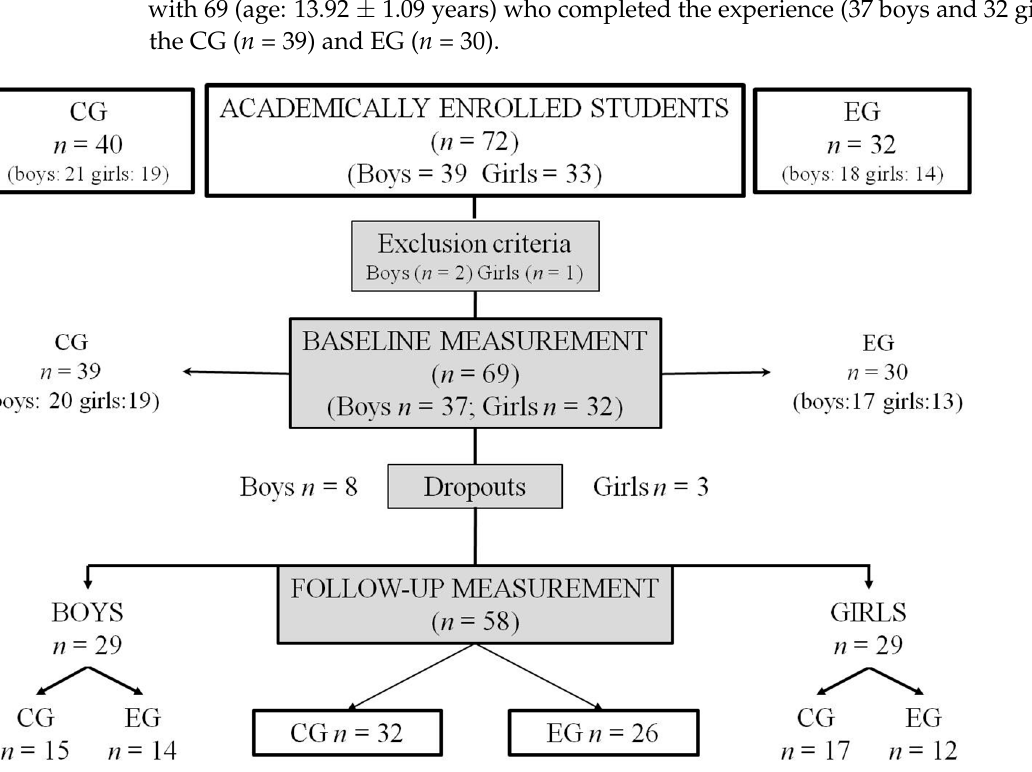
Figure 1. The flowchart of the students. EG: experimental group and CG: control group. The participants who, after starting the study, managed to finish it were 58 (80.55%): 32 in the CG and 26 in the EG. Eleven students (5 boys and 2 girls from the CG and 3 boys and 1 girl from the EG) did not complete the study due to dropping out of the study, with effects related to school absenteeism, absent from the PE classes above 20% ( n = 2), not answering the questions in the questionnaire or doing it wrong ( n = 5) and not feeling in adequate physical and mental condition to carry out the tests ( n = 4).